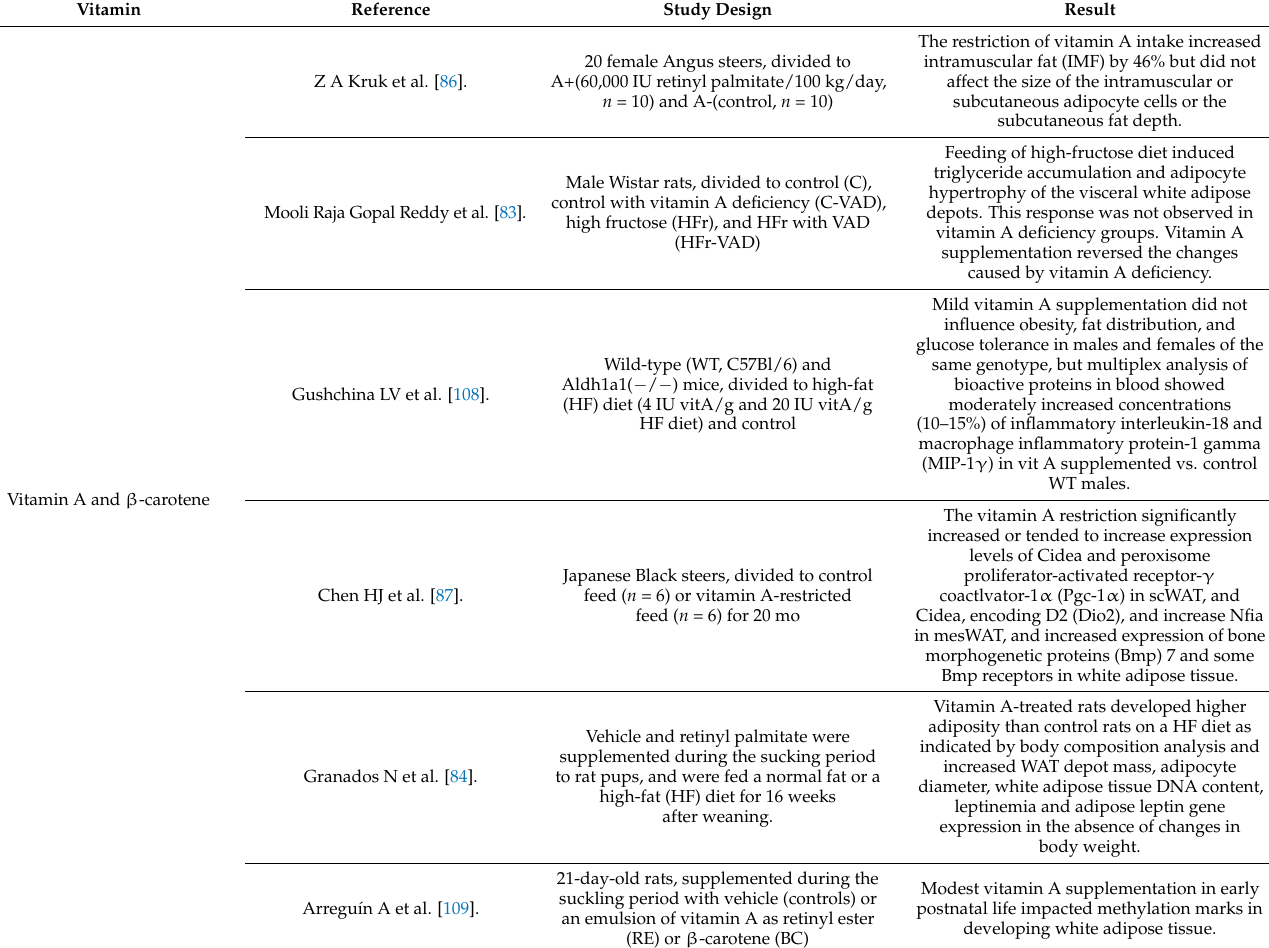
Table 2. Effect of dietary vitamin intake on adipose